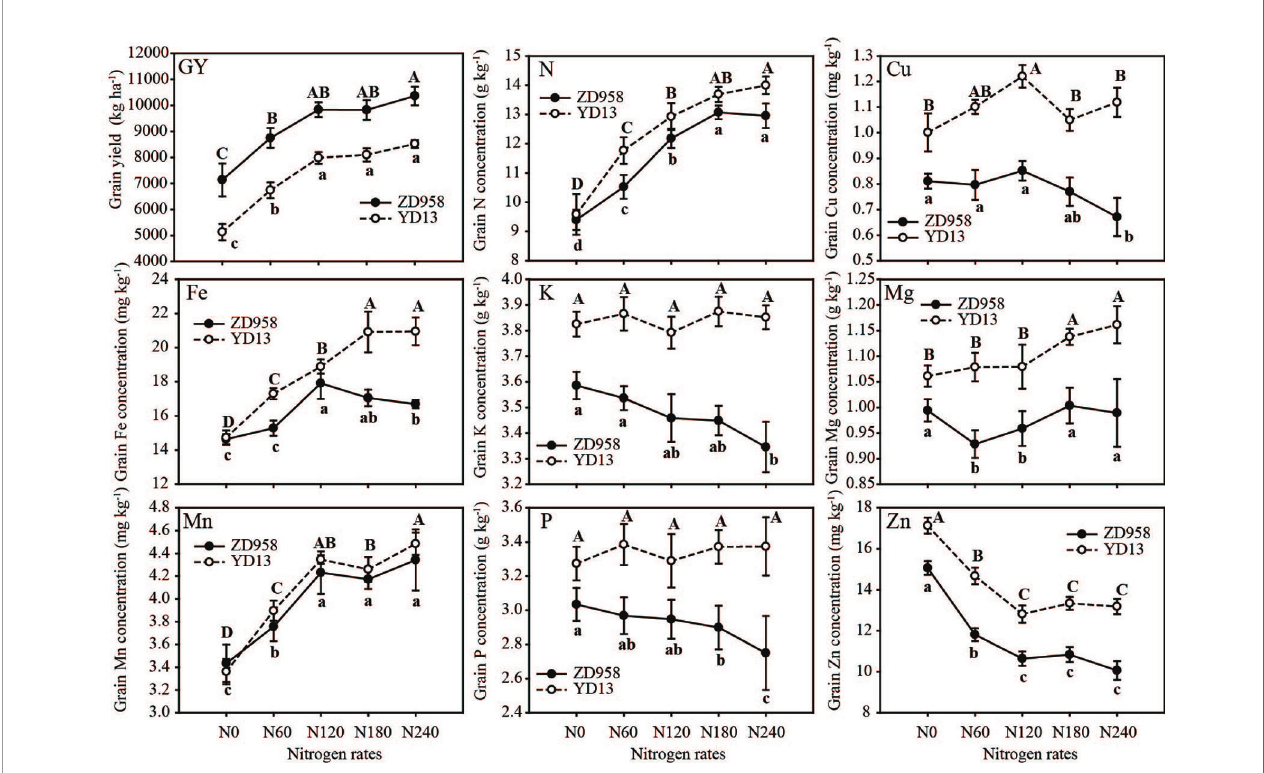
FIGURE 2 | Grain yield and grain nutrient (N, Cu, Fe, K, Mg, Mn, P, and Zn) concentrations in response to nitrogen treatment in hybrids ZD958 (closed circle) and YD13 (open circle). Data were collected in Fu-Jia-Jie (FJJ). N0, N60, N120, N180, and N240 represent N rates at 0, 60, 120, 180, and 240 kg ha − 1 , respectively. Data shown are means for cultivar in 2010 and 2011 ± SD (n = 8). Upper- and lowercase letters denote the results of t-test to YD13 and ZD958 at fi ve N rates, respectively. Any two samples with a common letter are not signi fi cantly different (P >